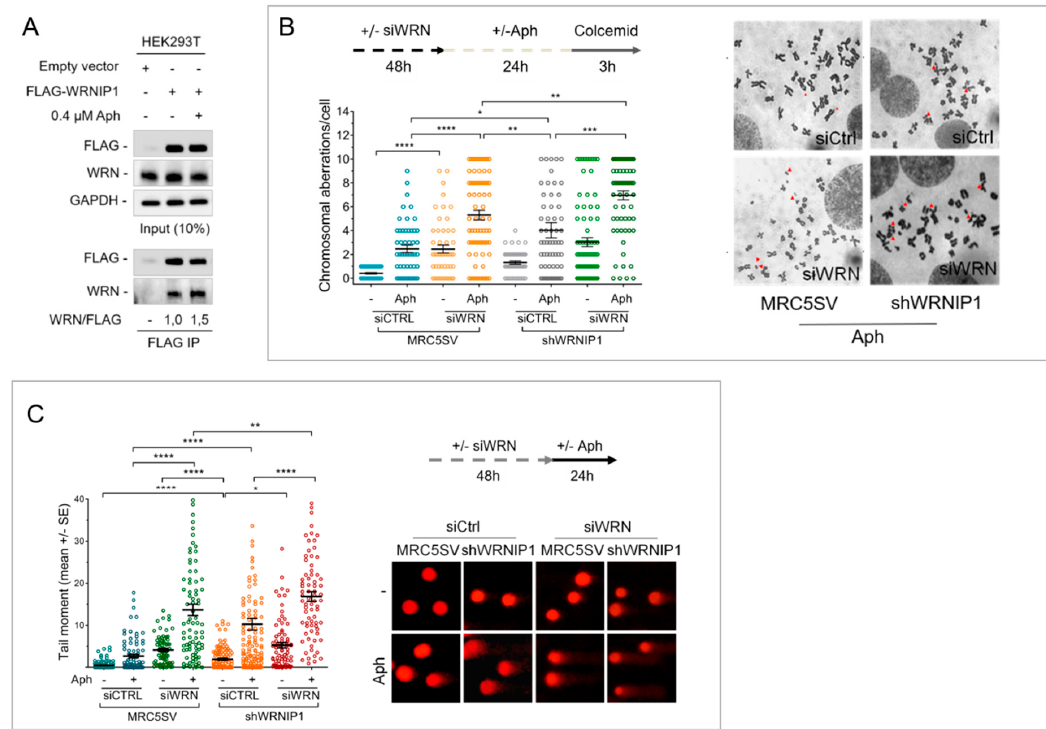
Figure 1. Loss of Werner Syndrome Protein (WRN) and WRNIP1 exacerbates genomic instability upon mild replication stress (MRS). ( A ) Co-IP analysis showing the interaction between WRN and WRNIP1 after IP with anti-FLAG antibody in HEK293T cell extracts, followed by Western blot with the indicated antibodies; ( B ) Analysis of chromosomal aberrations. Data are presented as chromosomal aberration per cell. Error bars represent standard error; ( C ) Alkaline comet assay in cells treated as in ( B ). Data are presented as tail moment ± SE from three independent experiments.